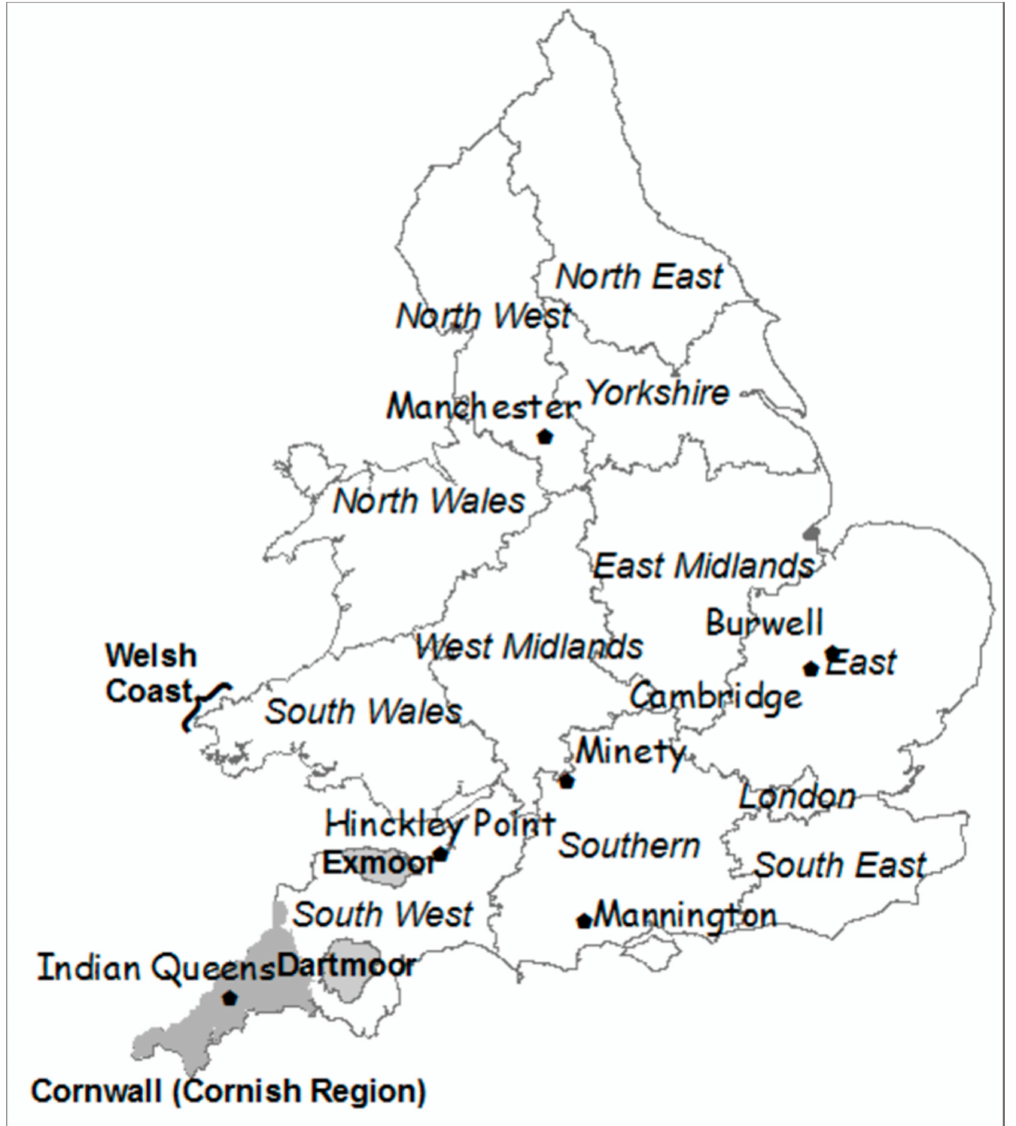
Figure A1. Map showing locations of all UK areas, cities and towns covered by this